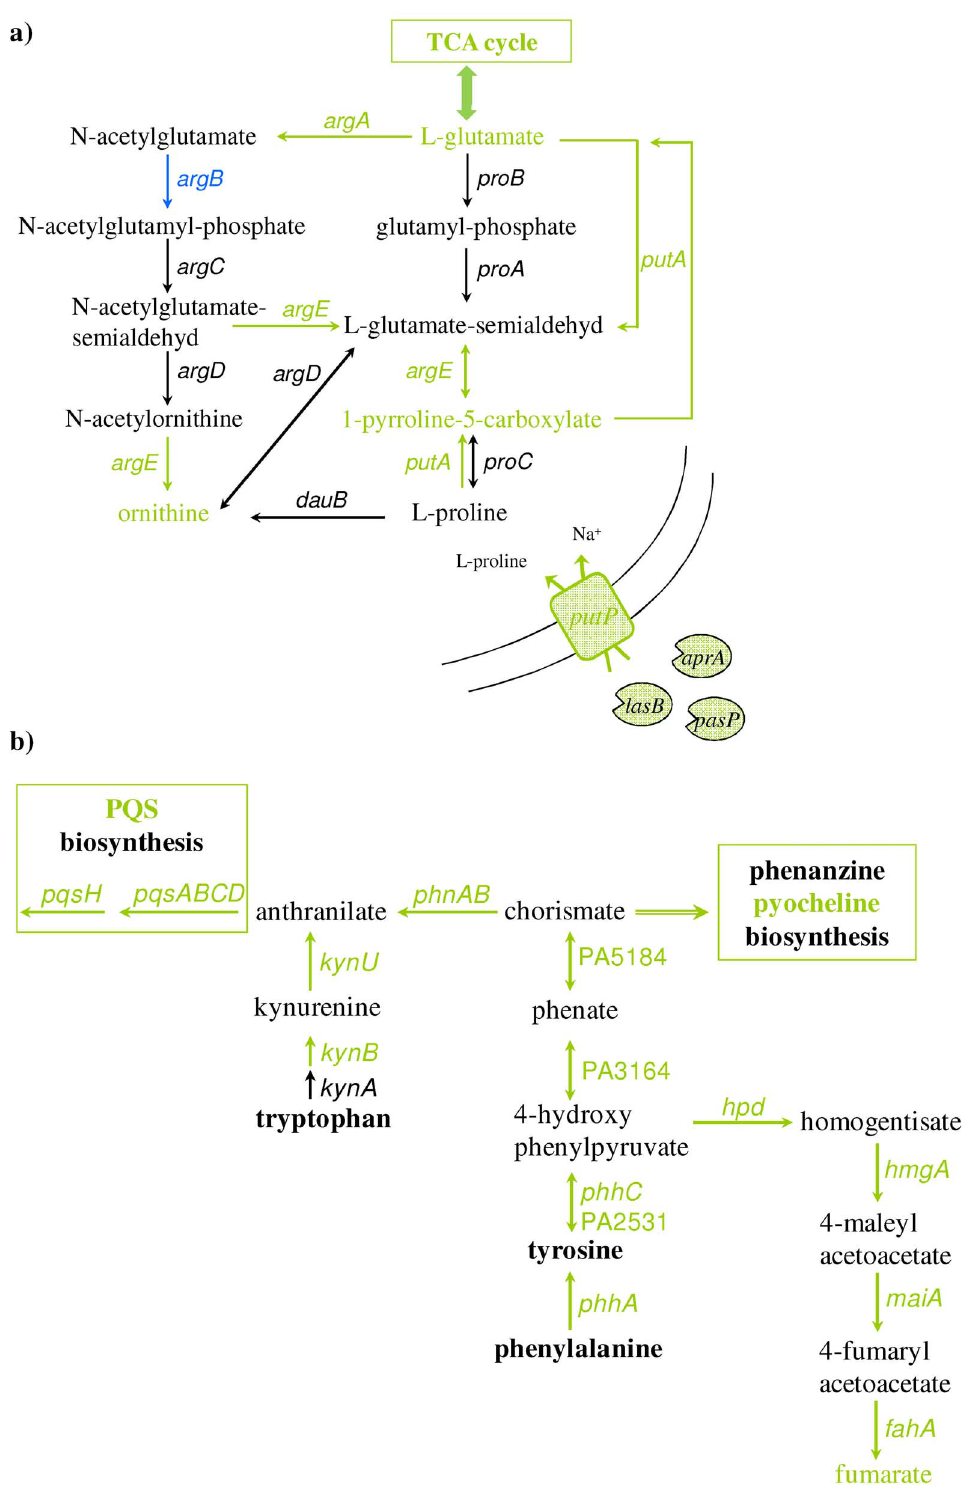
Figure 5. Degradation of aromatic amino acids as indicated by transcriptome and metabolome data. Degradation of a) proline and b) tryptophan, tyrosine and phenylalanine was shown. Pairwise comparisons of the transcriptome and metabolome data between biofilms grown anaerobically on AUM and 10-fold diluted LB supplemented with 50 mM nitrate were performed. Metabolite concentrations and gene expression levels found increased (green) or reduced (blue) in biofilms grown on AUM are displayed. Equally produced metabolites and expressed genes are marked in black.